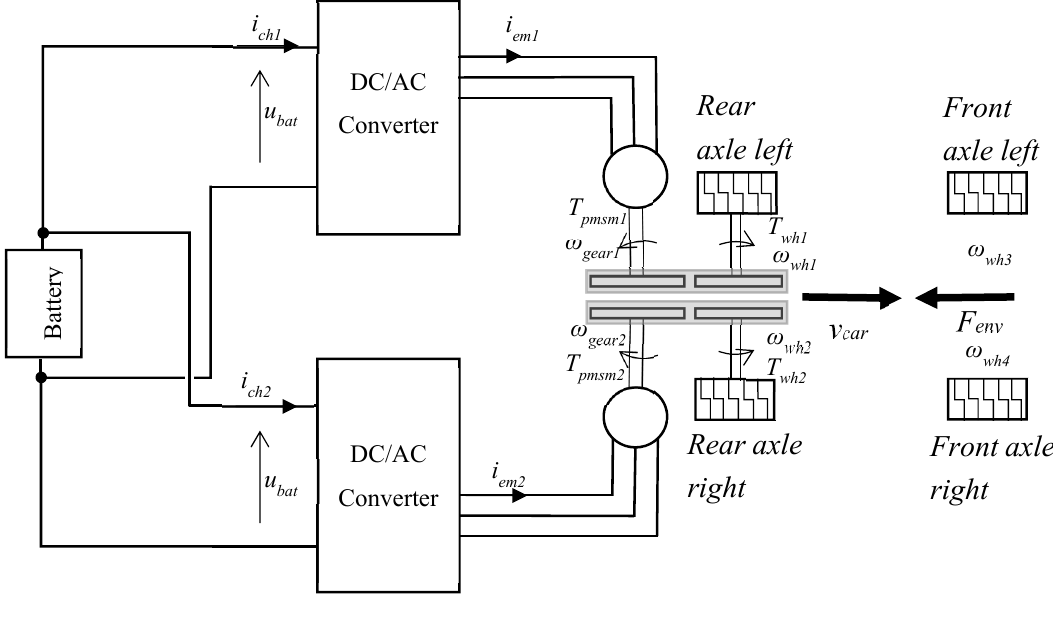
Figure 1. Structural representation of the race car.